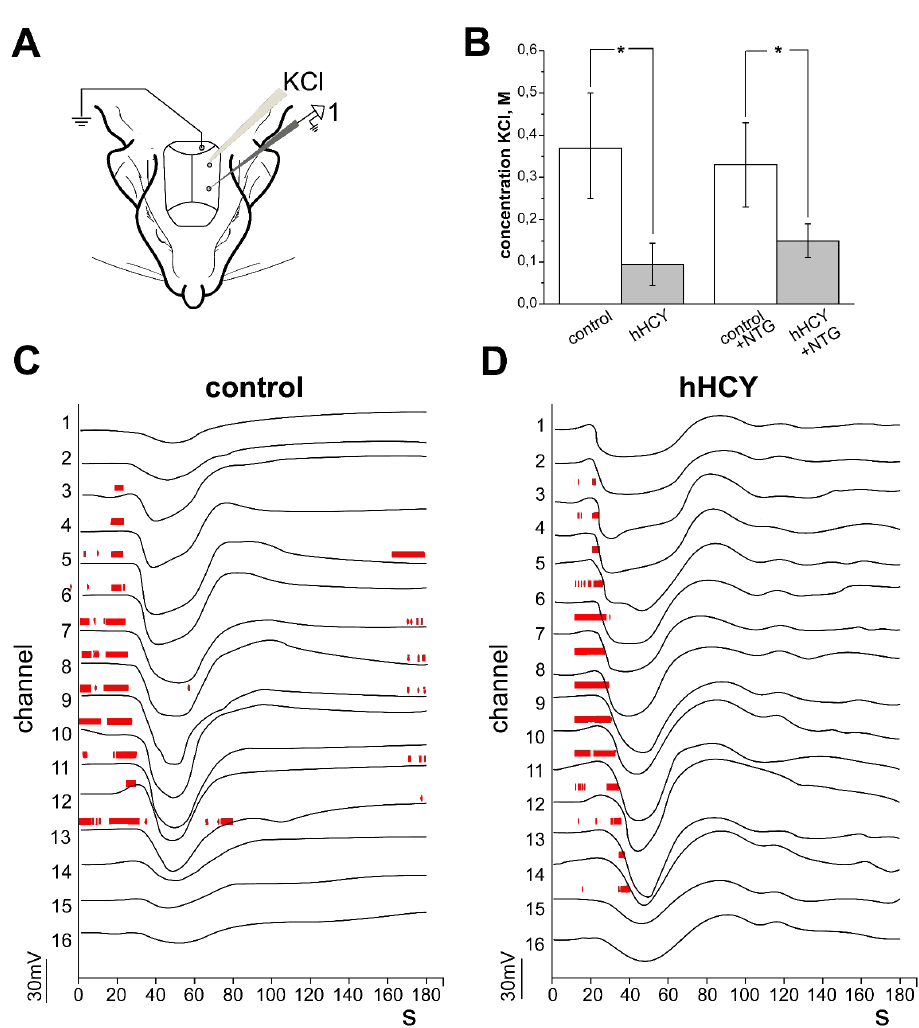
Figure 3. In vivo recording of cortical spreading depression (CSD) induced by KCl application and effects of nitroglycerine (NTG) on the threshold of CSD. ( A ) Schematic representation of the electrophysiological experiment. ( B ) The minimum KCl concentration inducing CSD before and after the administration of nitroglycerine in rats of the control (white columns) and hHCY (gray columns) groups. ( C , D ) Examples of KCl induced CSD recorded by a 16-site linear silicon probe (100 µ m distances between recording sites) in all layers of cortical columns of control ( C ) and hHCY ( D ) groups. The multiple unit activity (MUA) marked by vertical red lines were detected as negative events exceeding eight standard deviations in amplitude, * p < 0.05 compared to control